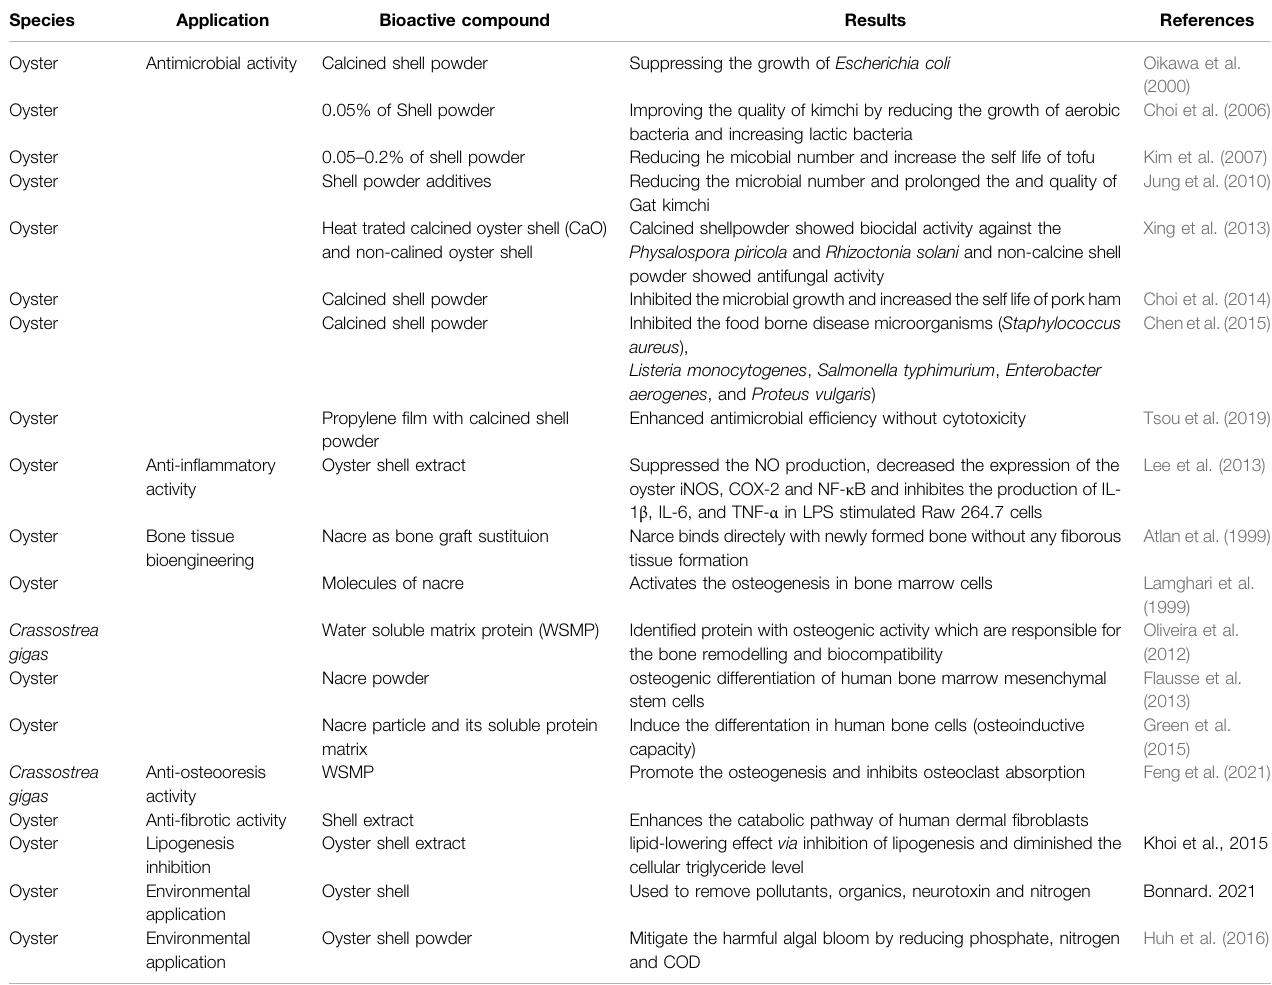
TABLE 1 | Bioactive compounds derived from oyster shell and their biological applications.